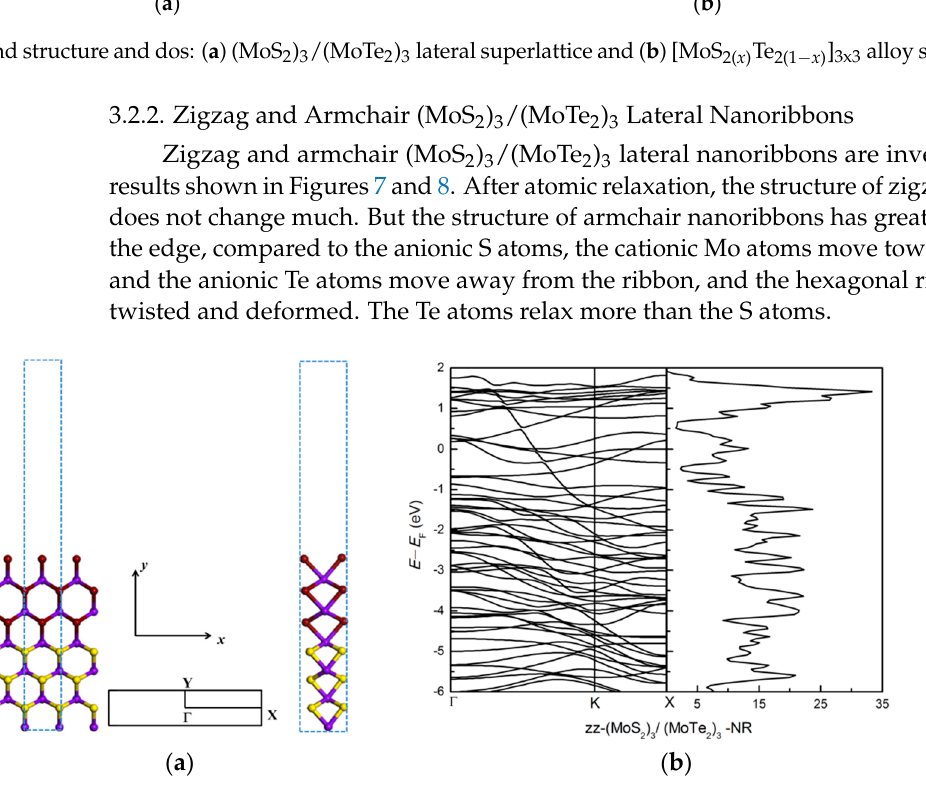
Figure 7. ( a ) The atomic structure of zz-(MoS 2 ) 3 /(MoTe 2 ) 3 -NR. The blue dotted rectangle shows the repeat unit cell in ( a ) and the high-symmetry points in Brillouin zone are marked. ( b ) The electronic band structure and density of states (dos). Purple ball represents Mo atoms, brown ball represents Te atoms, yellow ball represents S atoms.